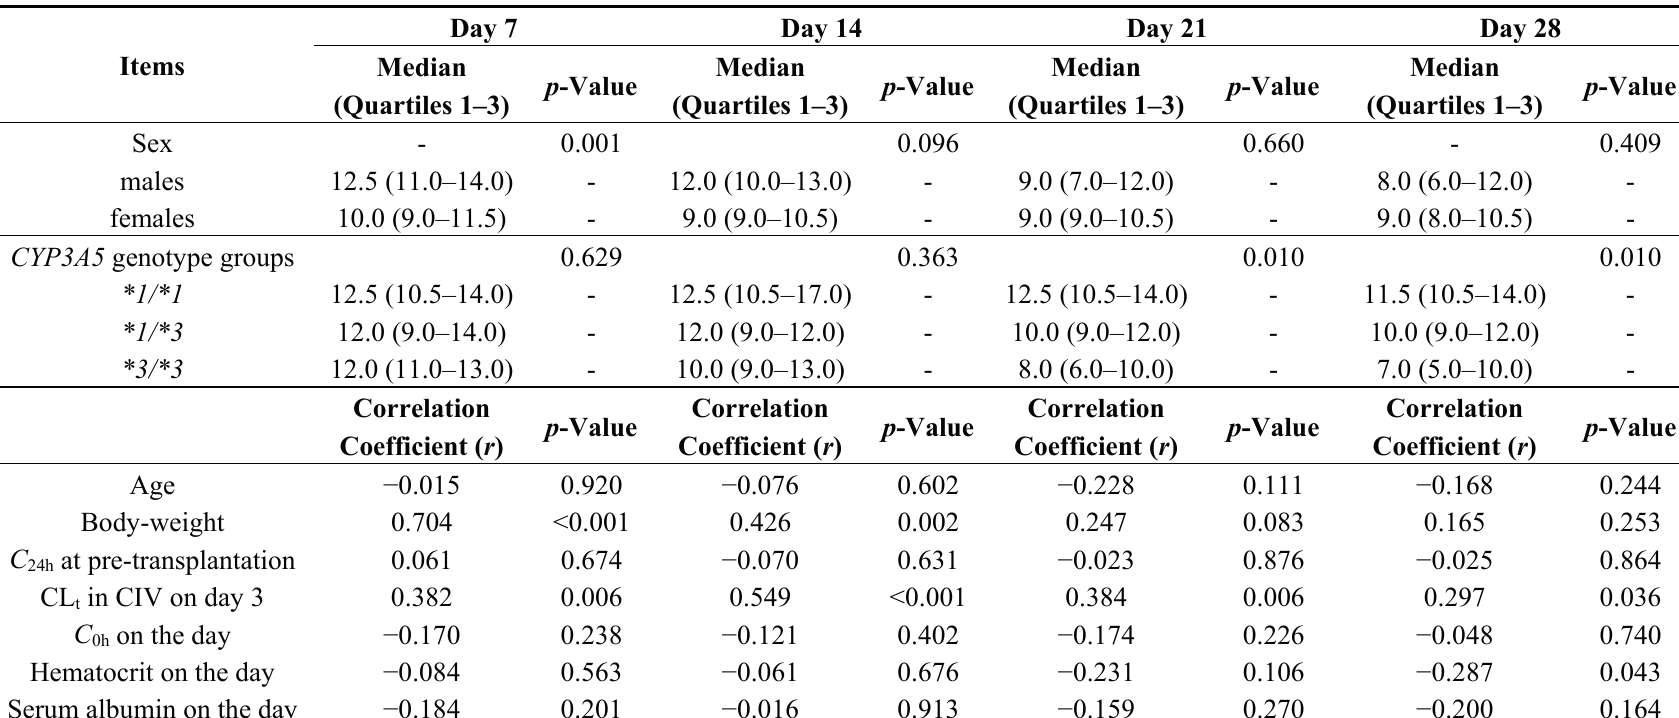
Table 2. Comparison and correlation with tacrolimus daily dose on Days 7, 14, 21 and 28 post-transplantaion and clinical characteristics or pharmacokinetic